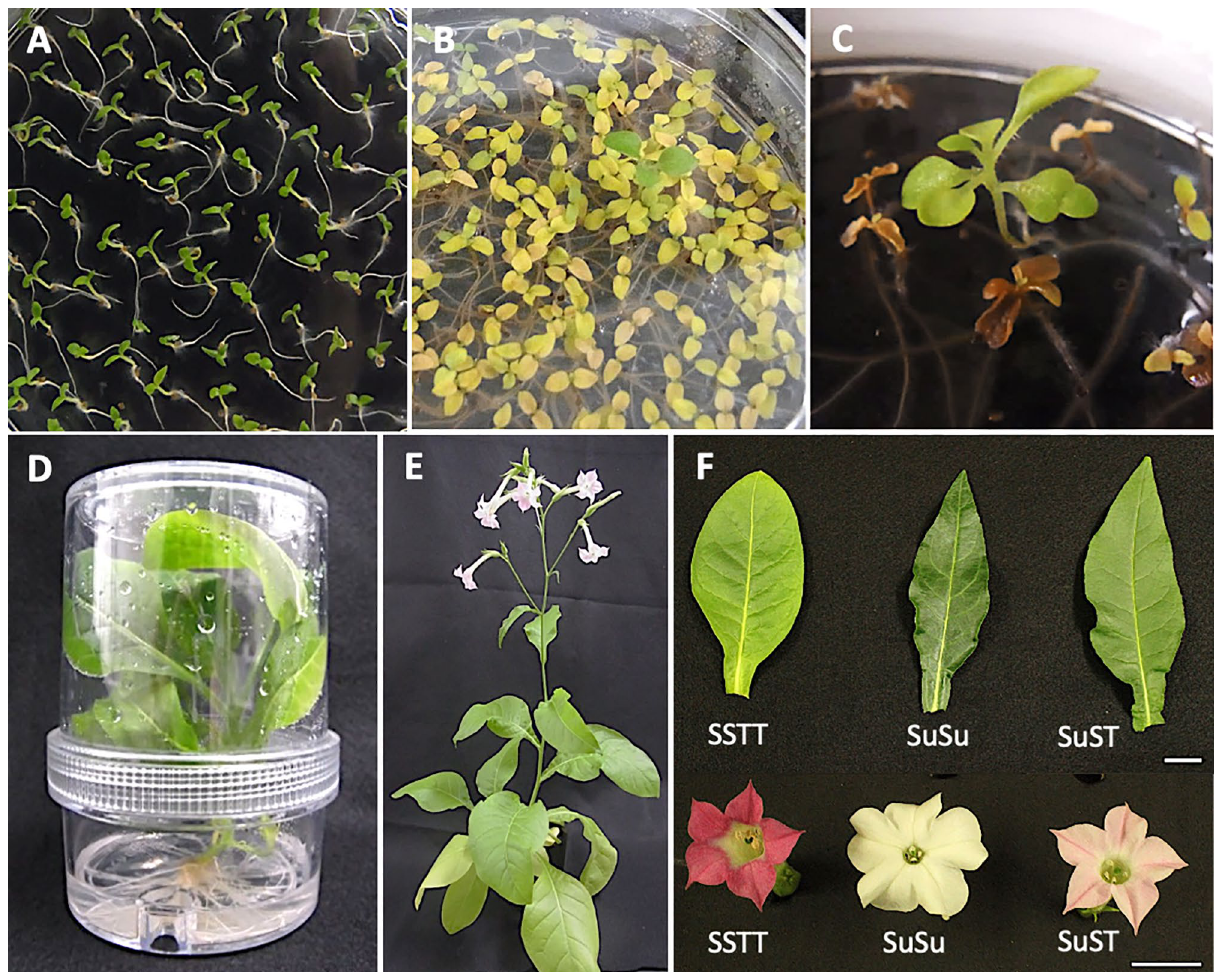
Figure 1. Process of obtaining hybrid viable seedlings. ( A ) Hybrid seedlings at 3 days after germination (DAG). ( B ) Seedlings at 14 DAG. ( C ) Seedling not showing lethality at 20 DAG. ( D ) Viable hybrid seedling cultured and propagated in a plant box. (E) Matured viable plant. (F) Leaf and flower phenotype of parents and hybrid plant. SSTT: N. tabacum , SuSu: N. suaveolens , SuST: N. suaveolens × N. tabacum . Scale bar: 2